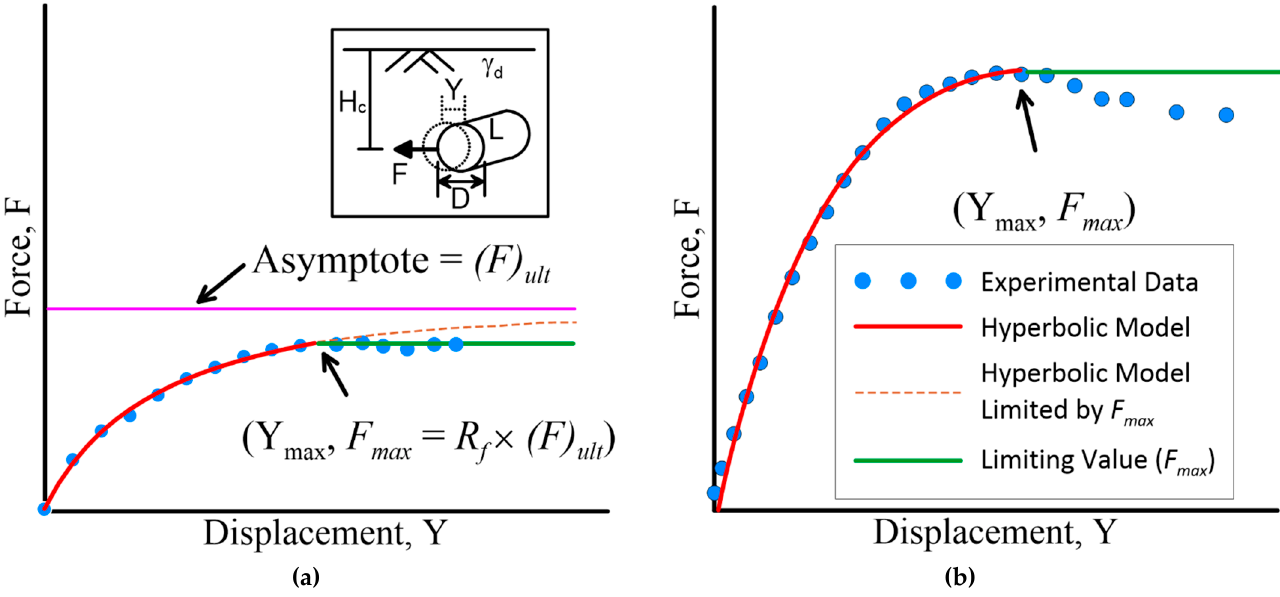
Figure 5. Determining F max and Y max from experimental data for ( a ) when a clear peak is not visible and ( b ) when a clear peak is visible (Reprinted with permission from Ref. [7]. Copyright 1983 ProQuest).